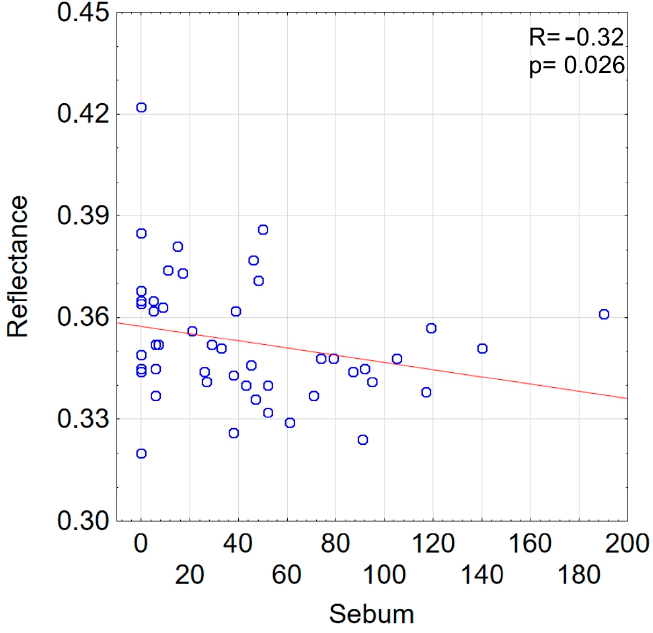
Figure 4. Correlation of sebum and skin reflectance at the wavelength 400–540 nm. Red line—trend line.